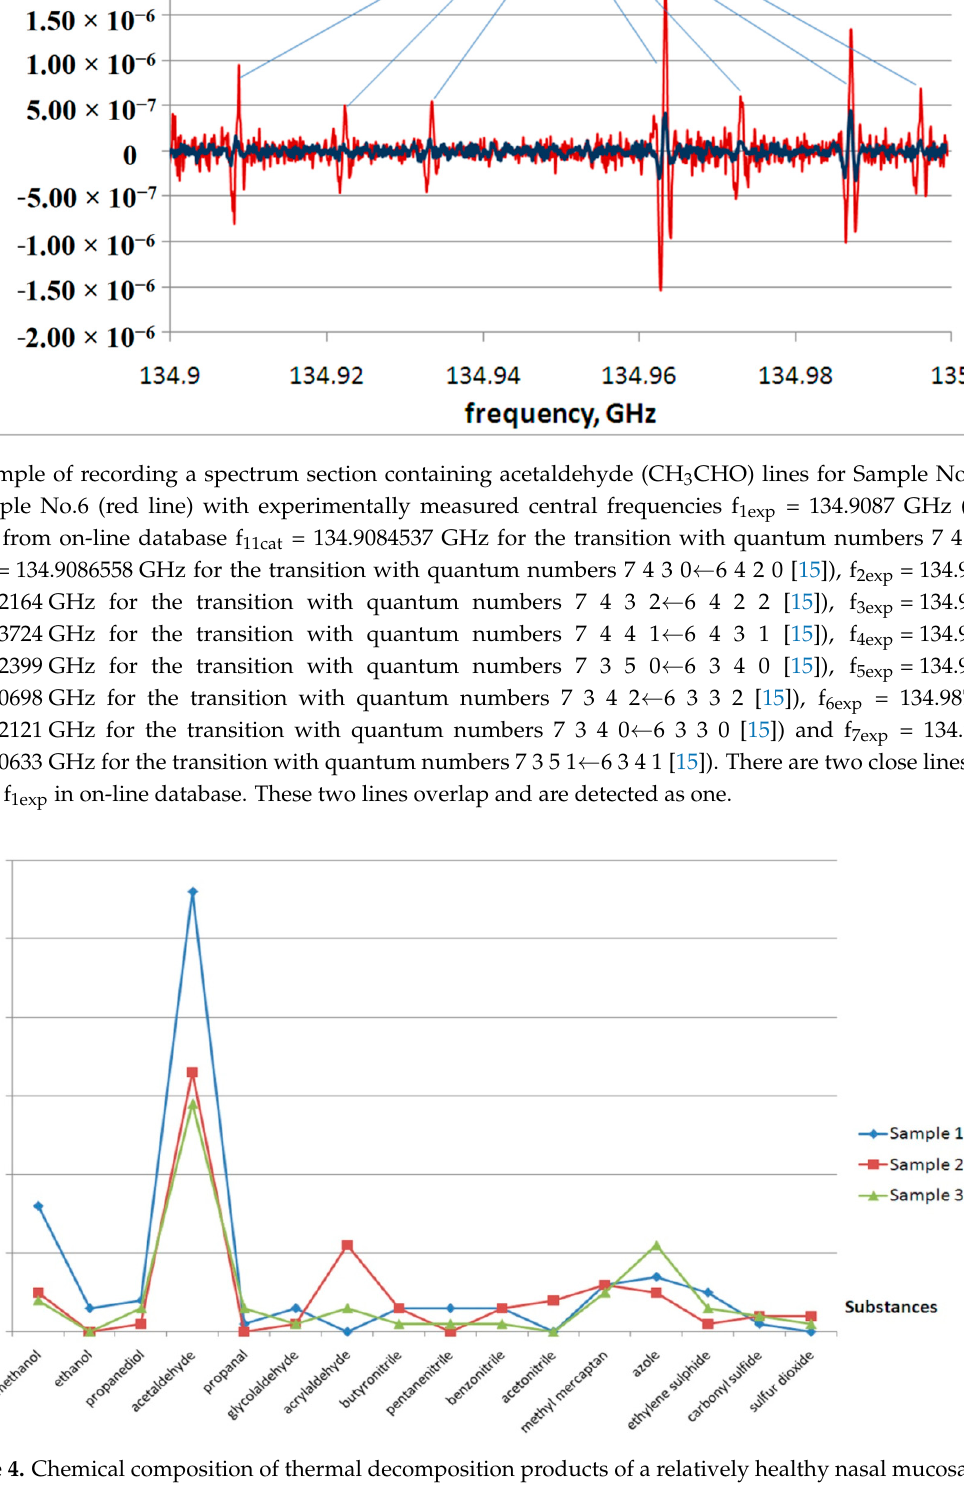
Figure 4. Chemical composition of thermal decomposition products of a relatively healthy nasal mucosa.